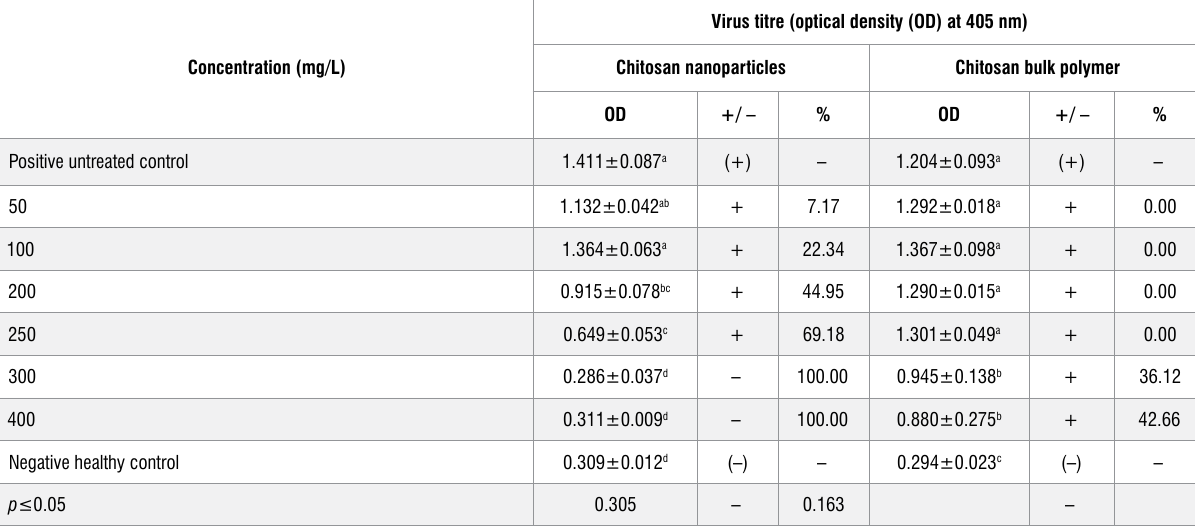
Table 1: Effect of chitosan nanoparticles and chitosan bulk form on virus concentration and accumulation contents in treated plants at six tested concentrations compared to healthy and infected untreated controls using ELISA reaction